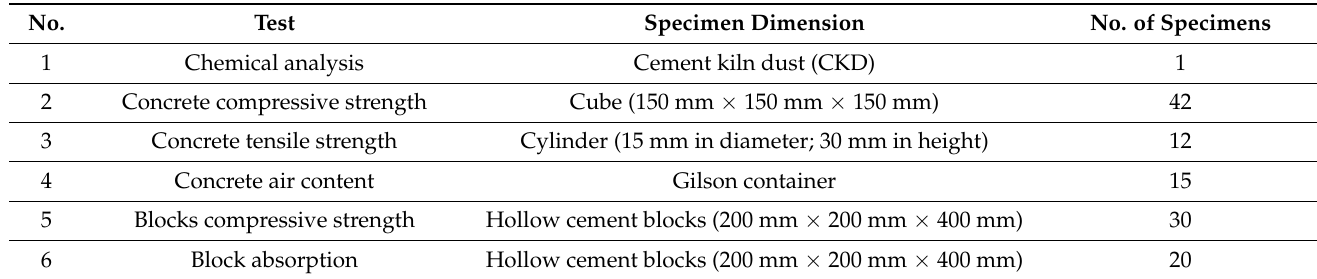
Table 1. List of tests and specimens